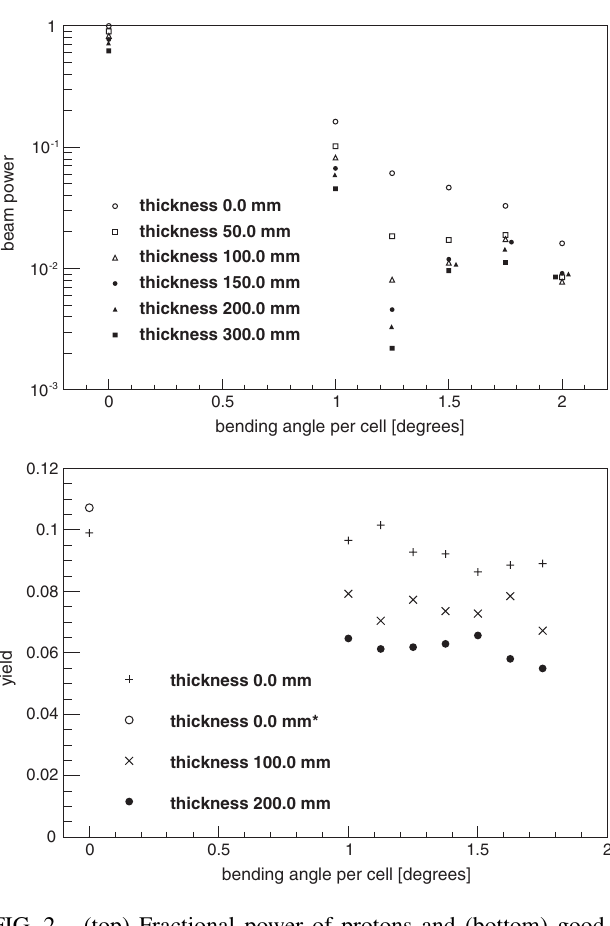
FIG. 2. (top) Fractional power of protons and (bottom) good muon yield at the end of the cooling channel for different chicane bending angles and absorber thicknesses. Overlapping points have been laterally displaced for clarity. The bending angle per cell is shown; each arc of the chicane was simulated with ten two-coil cells, each of which was rotated in the simulation to provide a smoothly varying solenoid field. No dipole field was applied. A cylindrical beryllium absorber was placed after the chicane with thicknesses listed. The two points for 0 mm thickness and 0 (cid:1) bending angle in the bottom figure assume ( þ ) ideal constant 1.5 T field and (*) 3D magnetic field maps. All chicane simulations use realistic magnet field maps. Simulation in G4BEAMLINE 2.06